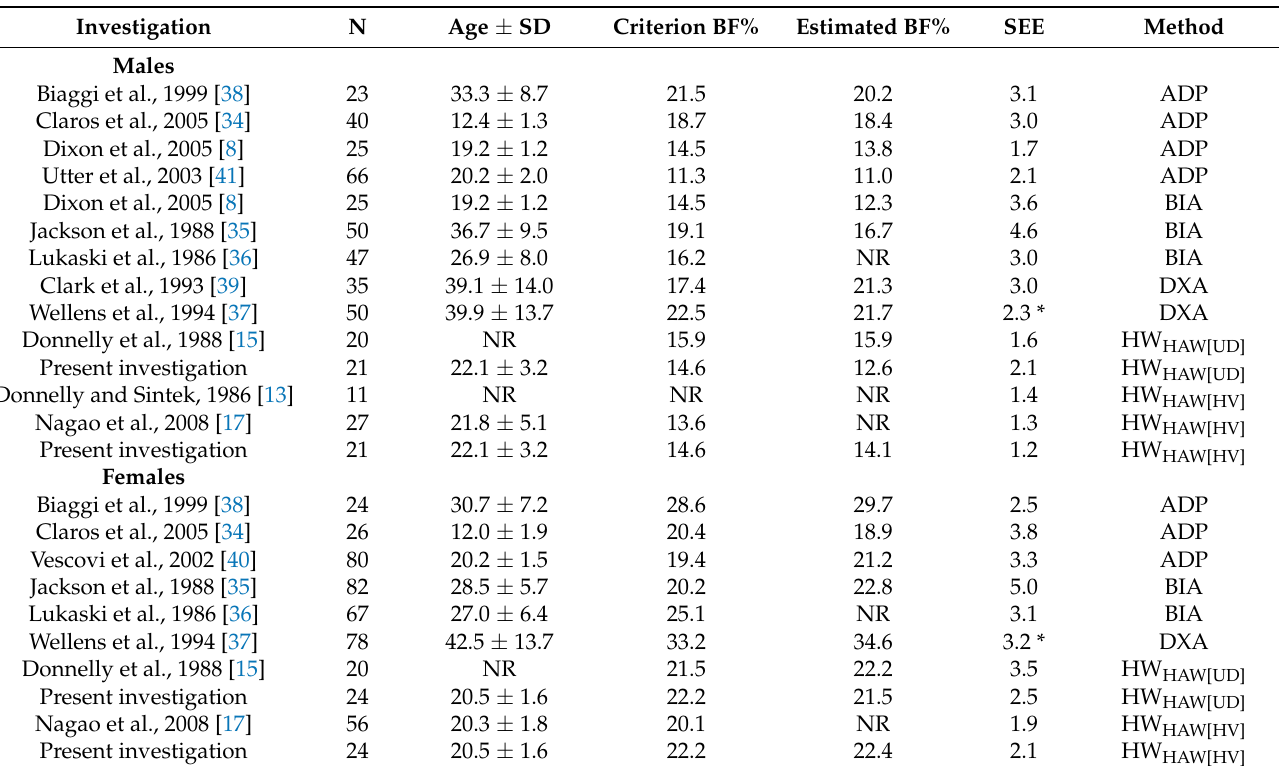
Table 4. Standard errors for estimation of body fatness from various methods, compared to hydro- static